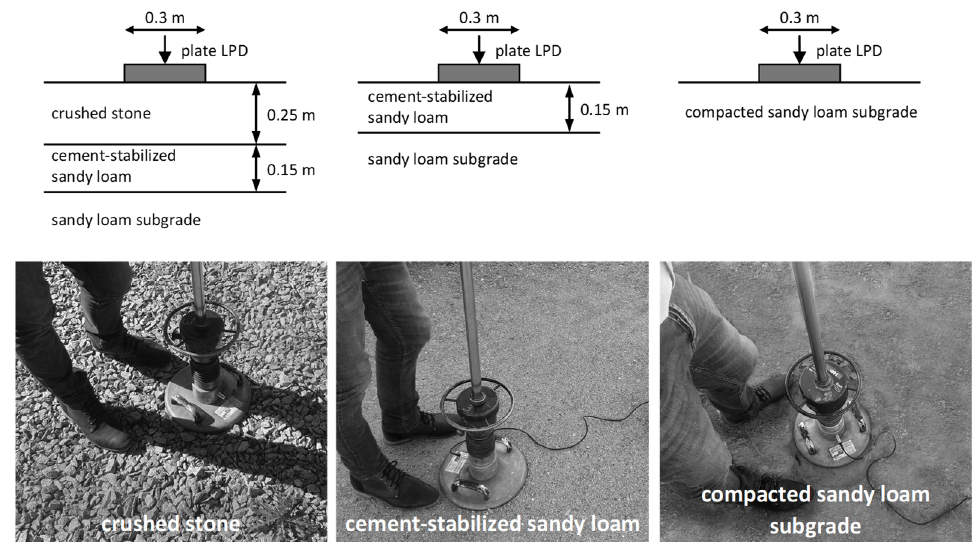
Figure 1. Test stands and diagrams of the tested structures.